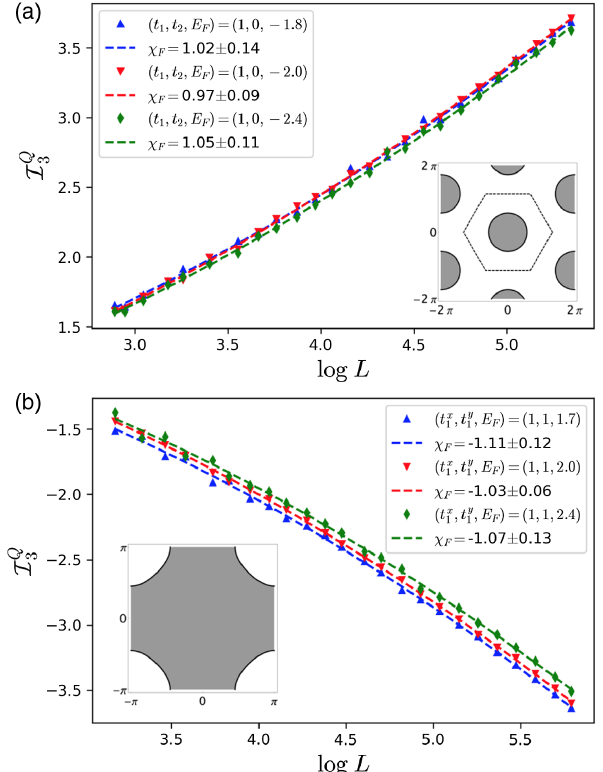
FIG. 5. Fitting analysis for (a) triangular lattice tight-binding 1 is model with one electronlike Fermi surface; thus χ F ¼ expected; (b) for square lattice with one holelike Fermi surface; − 1 is expected. Our results show collapse of data thus χ F ¼ points for Fermi sea with varying geometry but the same topology. Fitting demonstrates that I Q 3 scales as log 2 L , with a nearly quantized coefficient that encodes the Fermi sea topology, and is insensitive to the geometry of tripartition. Insets show the filled Fermi sea (shaded in gray) in corresponding setups. Details on optimizing the fitting analysis are presented in Appendix E.